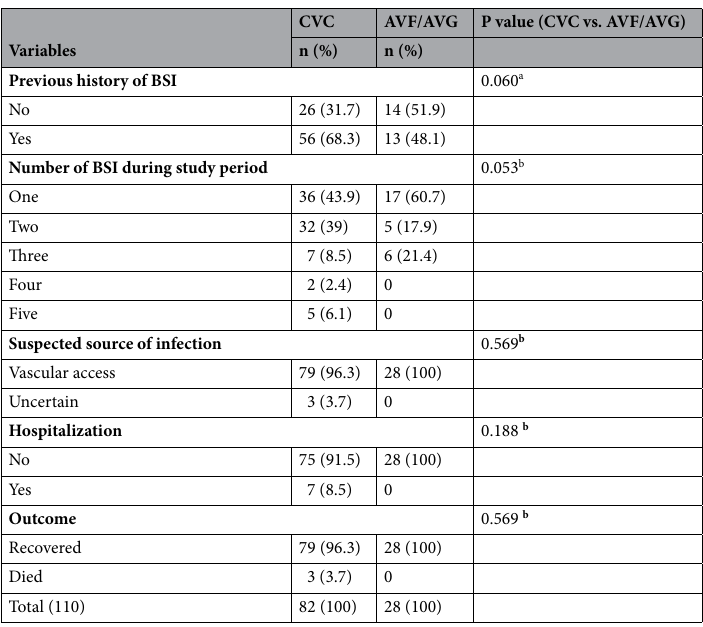
Table 2. BSI features by vascular access type (merged AVF and AVG). CVC central venous catheter, AVF arteriovenous fistula, AVG arteriovenous graft, BSI bloodstream infection. a Chi-square test. b Fisher’s exact